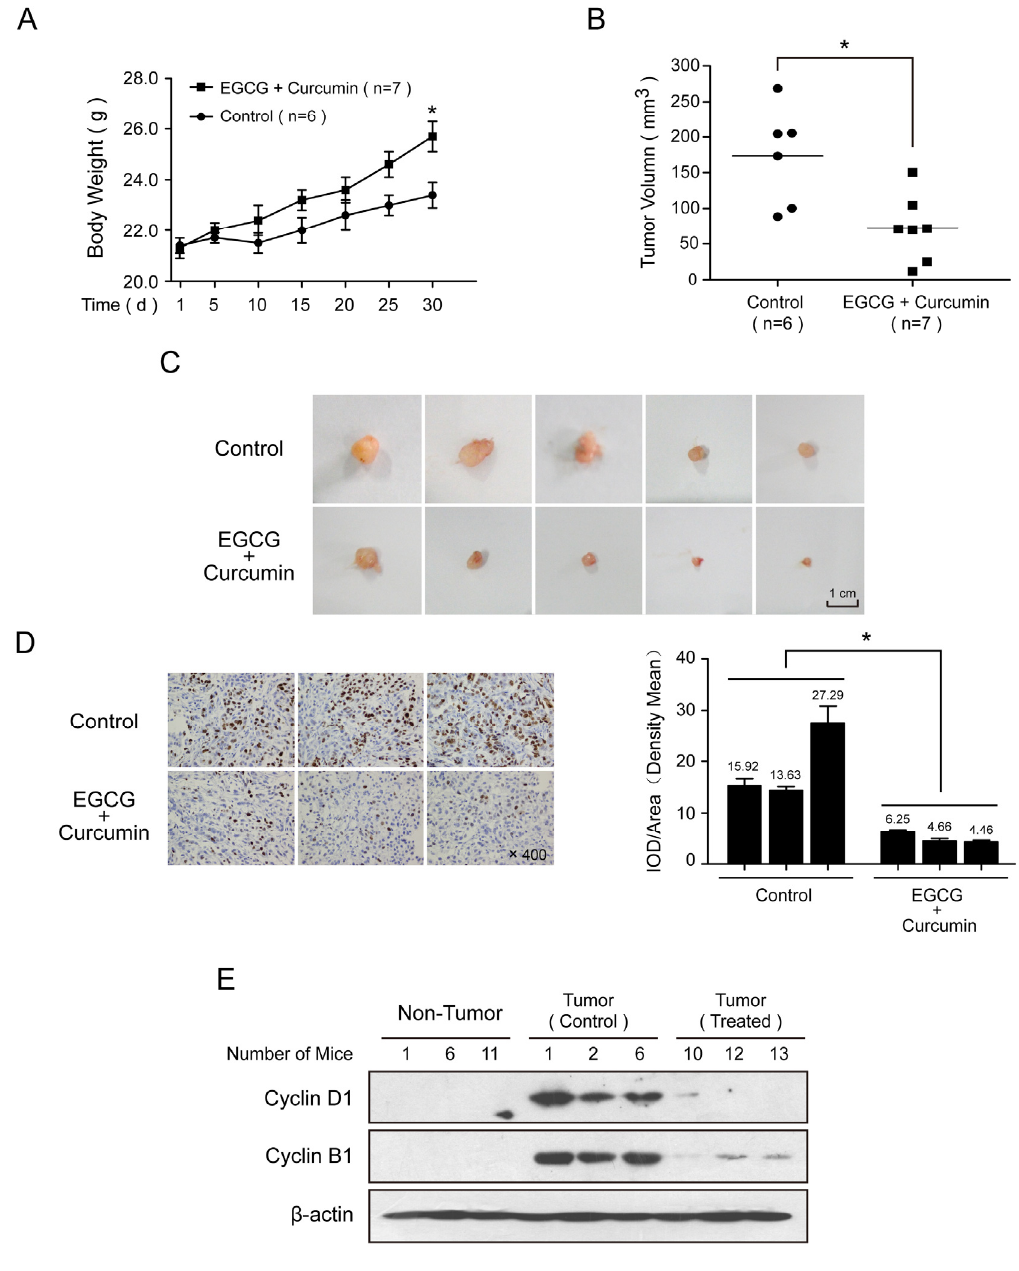
Figure 6. EGCG and curcumin inhibited the tumor growth in lung cancer xenograft nude mice. Fourteen 3 to 4-week old female BALB/c nude mice were i.p. implanted with 5 × 10 6 A549 cells. At the third day after the A549 cells injected, the mice were randomized into two groups (7 mice/group) and treated with control (NS, 100 mL/kg) or EGCG and curcumin (20 mg/kg, respectively). All the compound(s) was/were administered every other day for 4 weeks through intraperitoneal injection. On the 30th day, all animals were sacrificed. The body weight ( A ) and tumor size ( B and C ) were recorded every day; ( D ) Left : Immunohistochemistry staining of Ki-67. Right : The density mean of Immunohistochemistry staining; ( E ) Western blot was performed to detect the expression of cyclin B1 and cyclin D1. (* p <